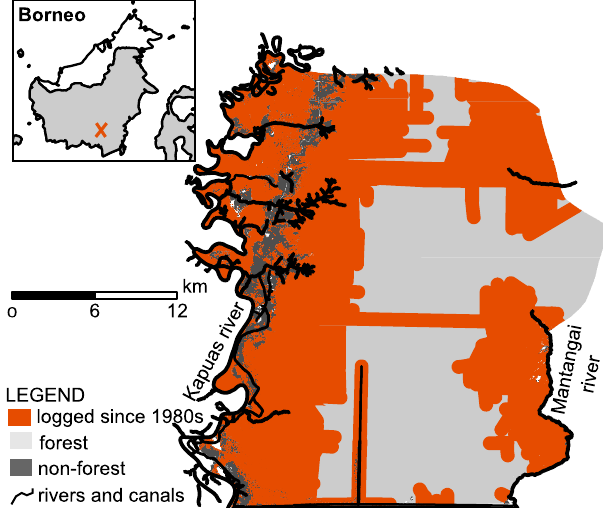
Figure 1. Map of old-growth (light grey), selectively logged forest (red) and non-forest (dark grey) within the 750km 2 Mawas land- scape, Indonesian Borneo (location shown in inset). Full red zones indicate areas affected by selective concessionary timber extraction until 2000 and illegal selective logging thereafter as estimated from logging routes detected in historical satellite imagery